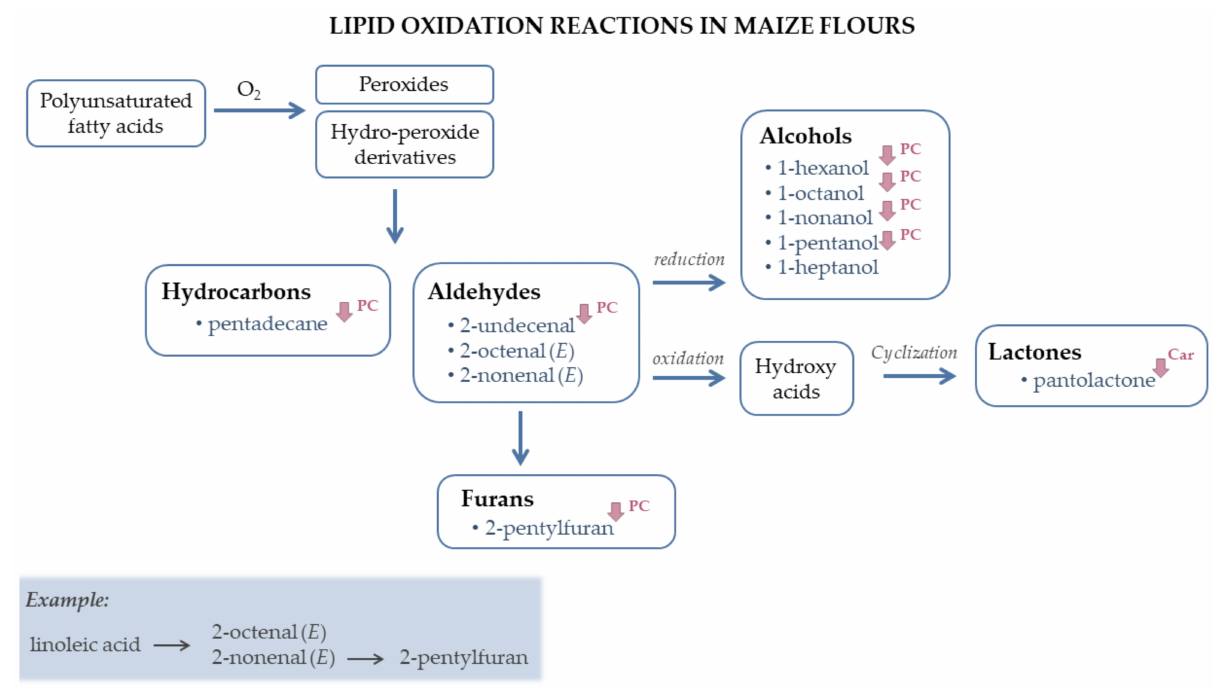
Figure 2. Representative scheme of lipid oxidation reactions [15,17,20,28,35] occurring in maize flour